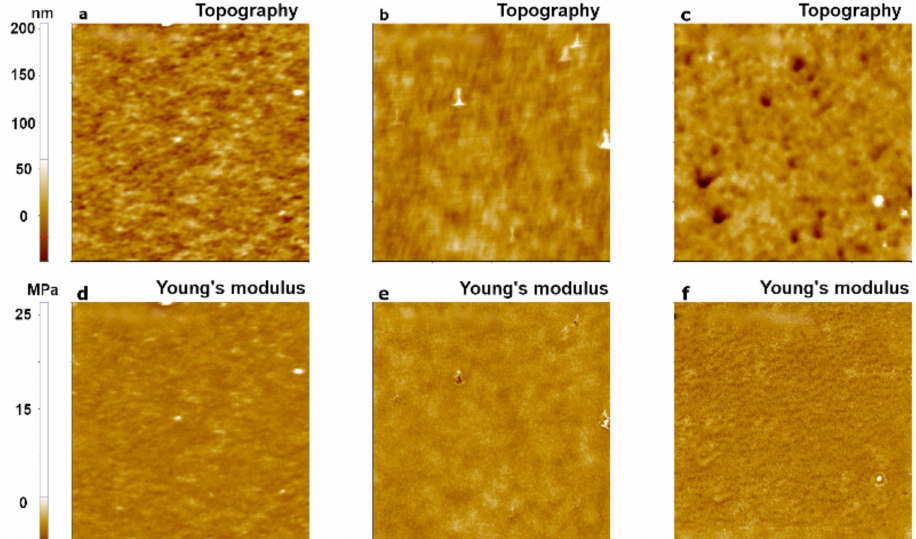
Figure 6. PinPoint TM nanomechanical images of a PDMS sample using three AFM cantilevers with different spring constants: 0.2 N/m for CONTSCR ( a , d ), 2.8 N/m for FMR ( b , e ), and 42 N/m for NCHR ( c , f ). The scan size of all images was 10 µ m × 10 µ